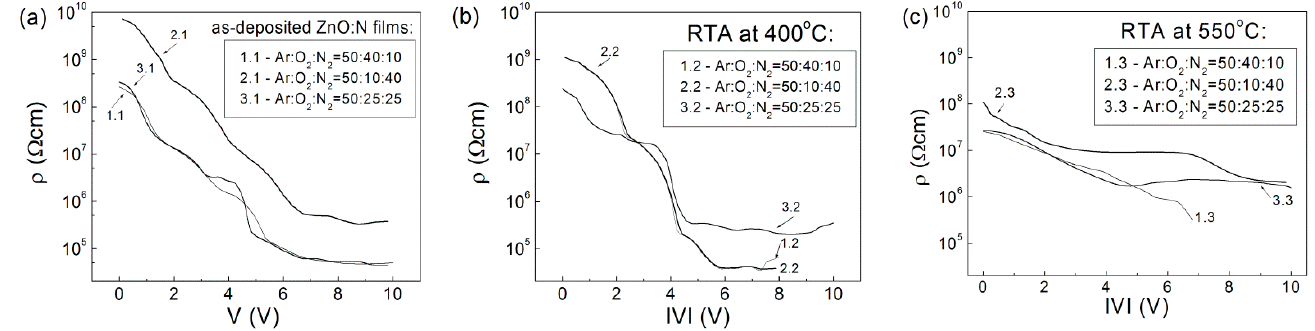
Figure 4. Specific resistivity ρ (V) versus applied forward voltage of ZnO:N films (deposited at different gas ratios ( a ) and after RTA at 400 °C ( b ) and 550 °C ( c ). The ρ values were calculated from the forward I–V curves shown in Figure 3.